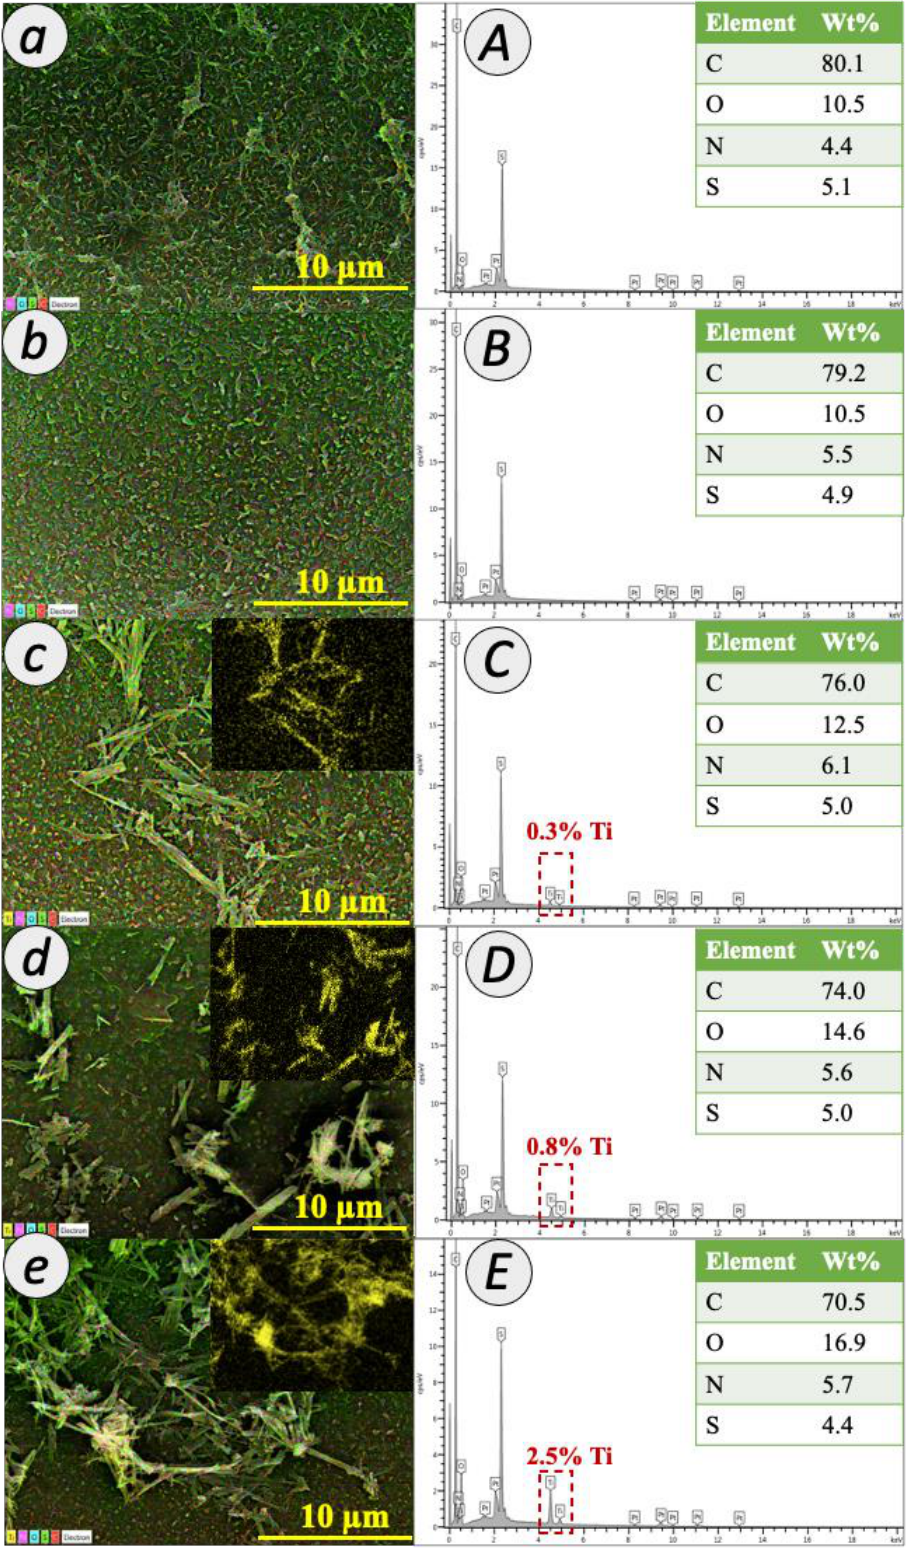
Figure 5. EDX mapping ( a – e ) and composition ( A – E ) of TFC and TFN membranes. Figure 6 demonstrates the three-dimensional AFM images and the corresponding roughness value for the TFC and TFN membranes. The topological characteristics of the